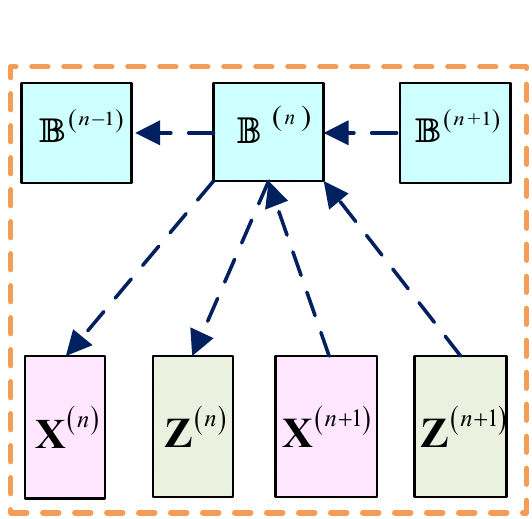
Figure 7. Back ‐ propagation of the multiplier update layer. Figure 7. Back-propagation of the multiplier update